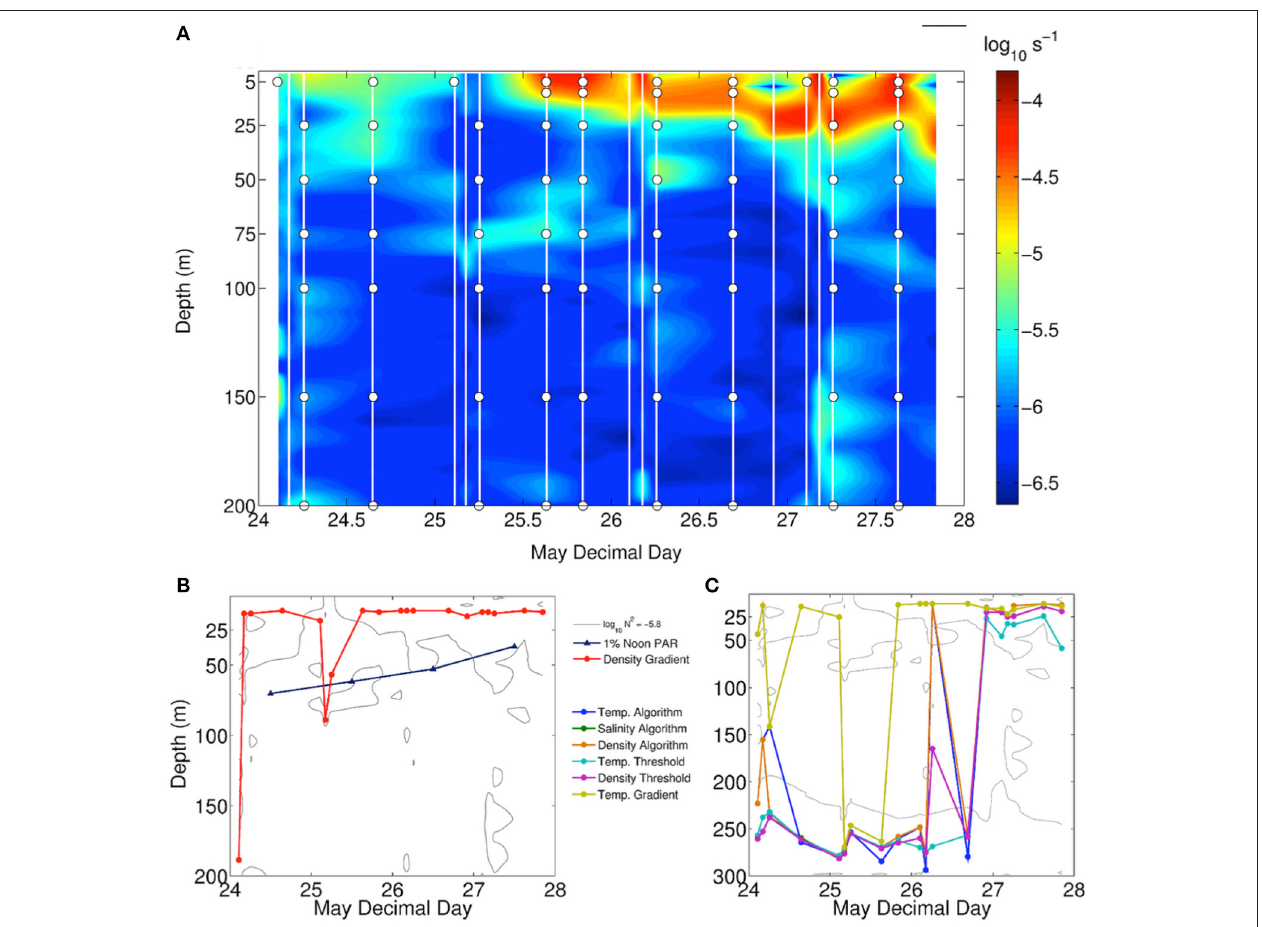
FIGURE 2 | (A) Contour plot of the buoyancy frequency during station occupation, times of CTD casts (white lines) and sample depths (circles). (B,C) Mixed layer depth determinations from multiple approaches plotted against a single contour of buoyancy frequency evident in Figure 1 . (A) 1% noon PAR depth.